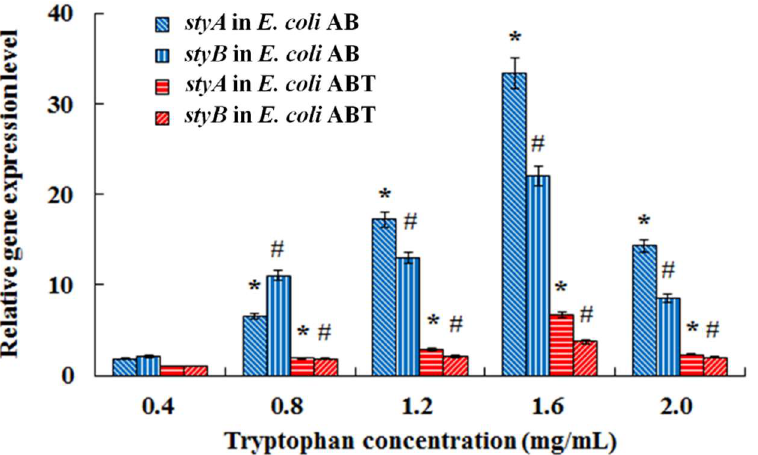
Figure 10. Transcriptional level assay of the genes styA and styB in E. coli AB and E. coli ABT in fermentation with different concentrations of tryptophan. Bars with asterisk (*) or pound sign (#) are significantly different ( p < 0.05).